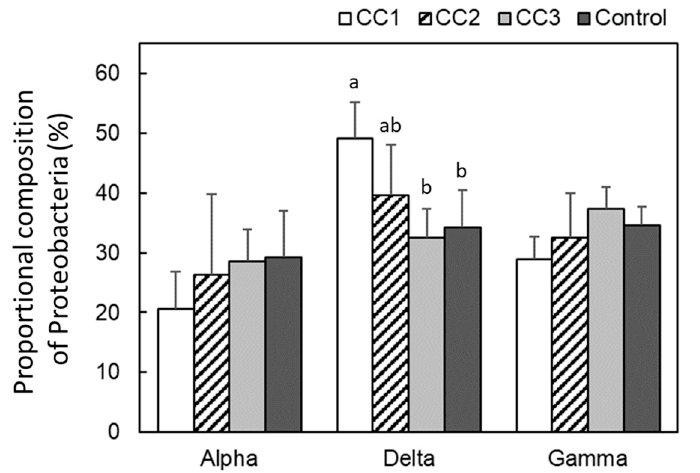
Figure 4. Proteobacterial compositions of each plot. Error bars show calculated standard deviations of each plot sample, including CC1, CC2, and the Control ( n = 6) and CC3 ( n = 8). Different letters (a and b) indicate significant differences between plots (Tukey’s HSD, p < 0.05).